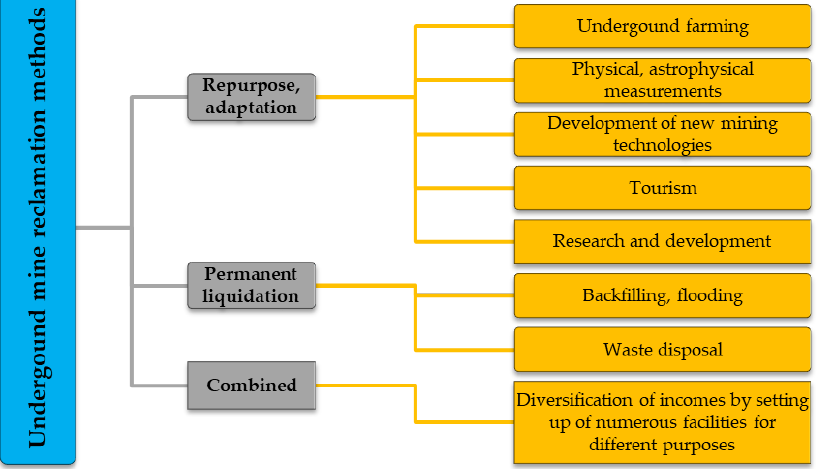
Figure 8. Prospective methods of underground workings repurposing according to surveys per- formed within the scope of EUL project.